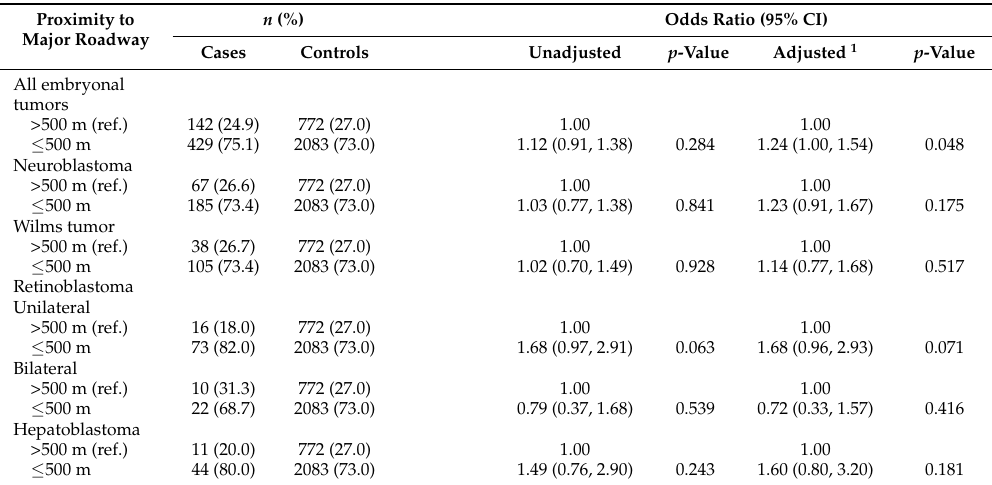
Table 3. Associations between maternal residential proximity within 500 m of a major roadway and embryonal tumors in